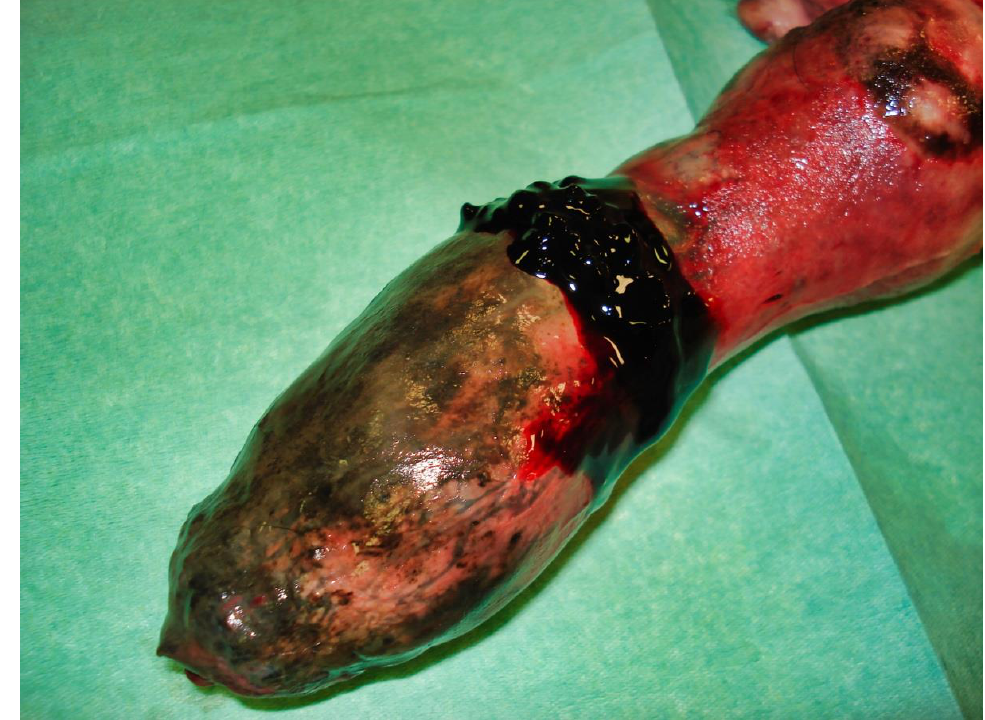
Figure 9. Black coagulum observed after incision of a necrotic area of the penis.